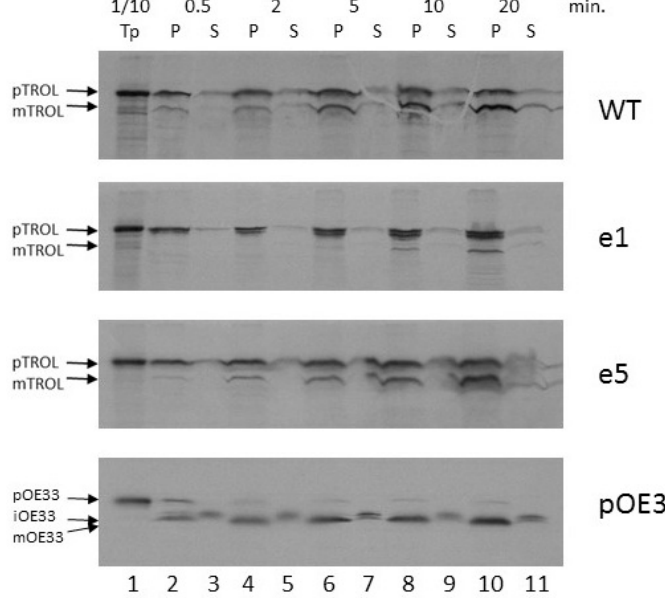
Figure 4. Time-scale import of wt TROL and e1 and e5 presequence mutants into intact pea chloroplasts. Radioactively labeled TROL, e1, e5, and control protein pOE33 were imported using increasing times in standard import reactions at 25 ° C in the presence of 3 mM ATP. Import was performed for 0.5 (lanes 2 and 3), 2 (lanes 4 and 5), 5 (lanes 6 and 7), 10 (lanes 8 and 9), or 20 min (lanes 10 and 11). After import chloroplasts were separated into the pellet (P, lanes 2, 4, 6, 8, and 10) and soluble (S, lanes 3, 5, 7, 9, and 11) fractions. Lane 1 indicates 1/10 of the respective translation product (Tp) used for the import reaction. Precursor (p), intermediate (i), and mature (m) forms of TROL, e1, e5, and OE33 are indicated by arrows.